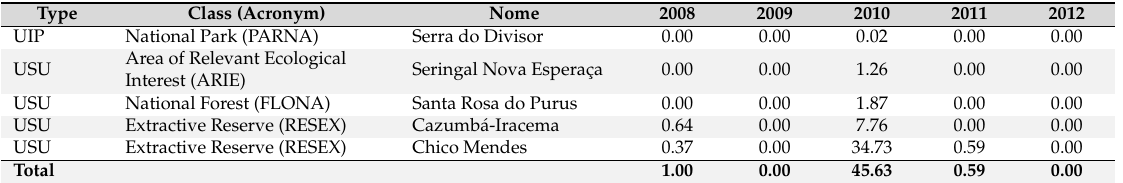
Table A8. Area (km 2 ) of Conservation Units affected by fire through the years analyzed.